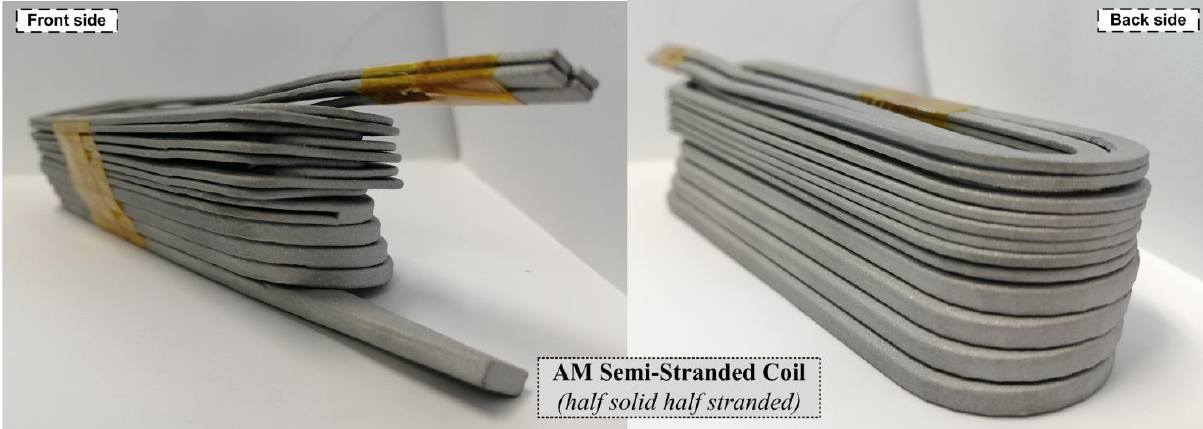
Figure 11. 3D printed semi-stranded coil with transposed strand location made using SLM of AlSi10Mg aluminum alloy.